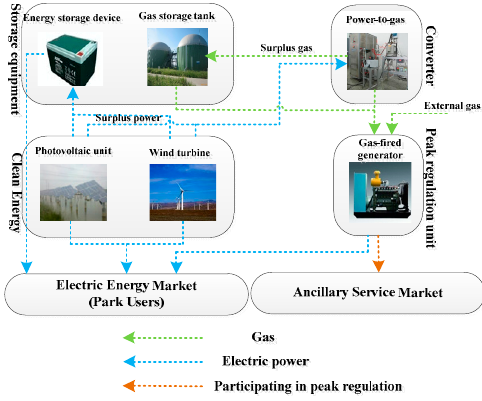
Figure 1. Park power supply system structure.